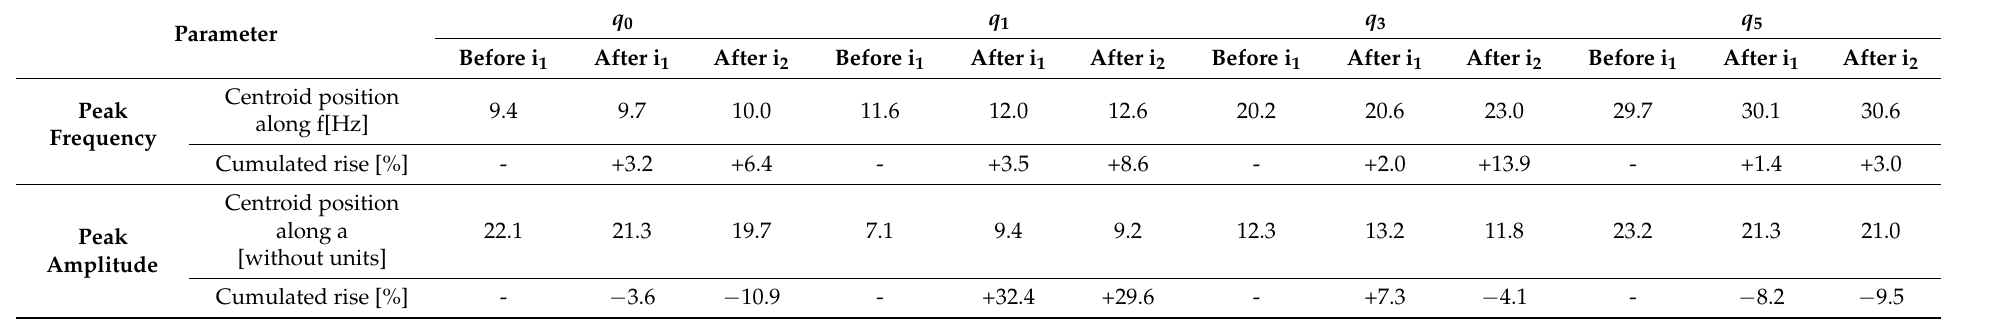
Table A4. HHSR changes between bolting